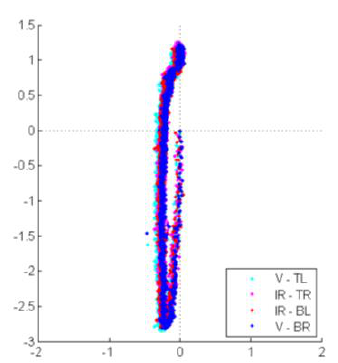
Figure 10 Trajectory of target image centroids (pixels).